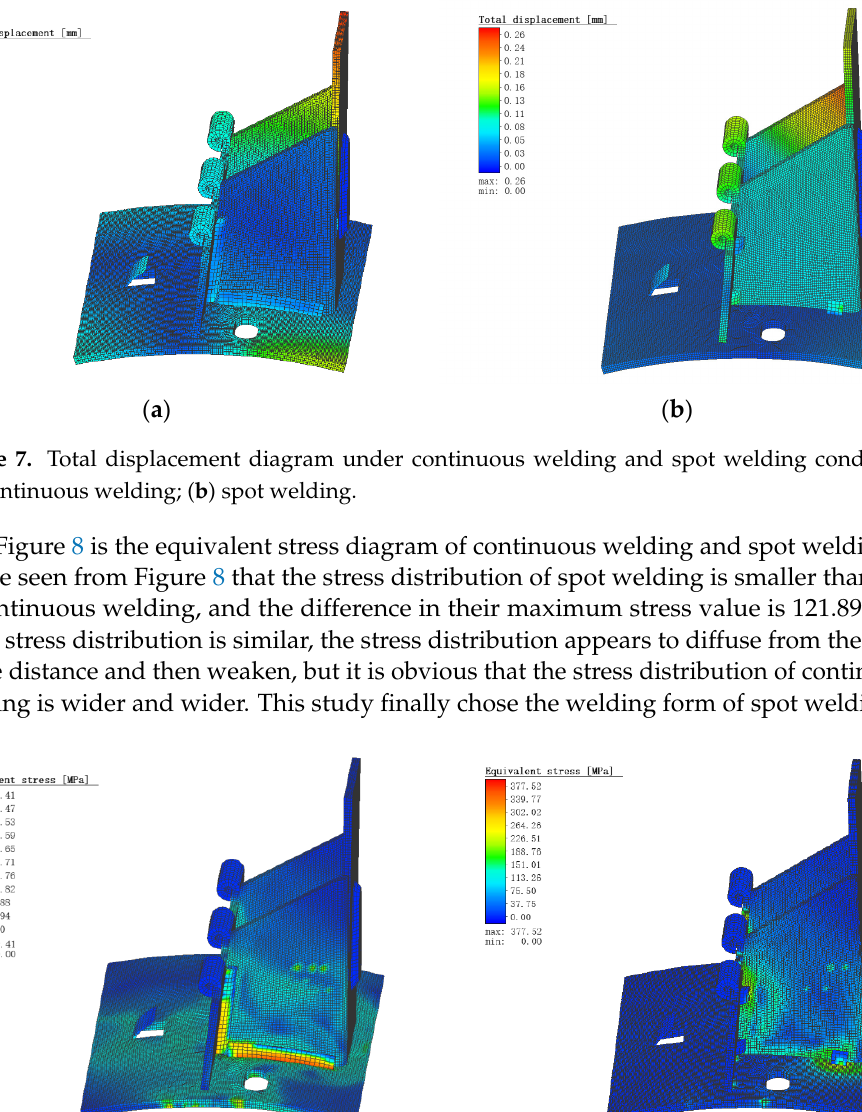
( b ) Figure 6. Equivalent stress diagram under the condition of the single welding torch and bilateral symmetrical double welding torch. ( a ) Single welding torch; ( b ) bilateral symmetrical double welding torch. 3.3.2. Effect of Welding Form on Welding Deformation and Stress